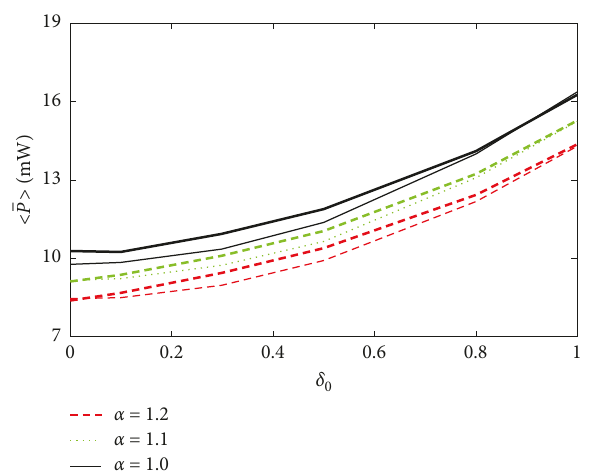
Figure 7: Comparison of the effective output power generated on the electric load ( R ) as a function of the parameter δ values of the mass disproportion parameter α ; thick lines: the bistable case ( Δ � 5mm); thin lines: the monostable case ( Δ � 15mm).